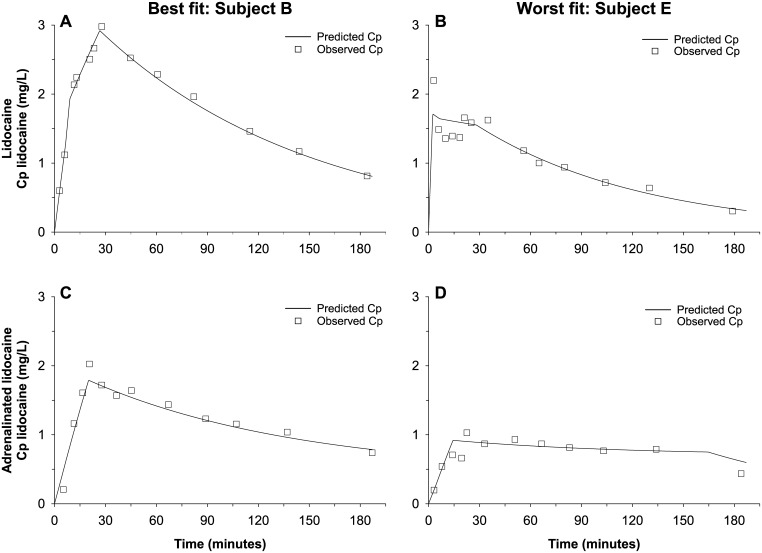
Best and worst fits to the individual time-courses of plasma lidocaine concentration in dogs.Predicted plasma lidocaine concentrations were generated by the refined alternative model (i.e. Model C, with two time-constrained, asynchronous zero-order drug absorption rates per system). (A) Best fit: Dog B, plain lidocaine data. (B) Worst fit: Dog E, plain lidocaine data. (C) Best fit: Dog B, adrenalinated lidocaine data. (D) Worst fit: Dog E, adrenalinated lidocaine data. Cp, plasma drug concentration.